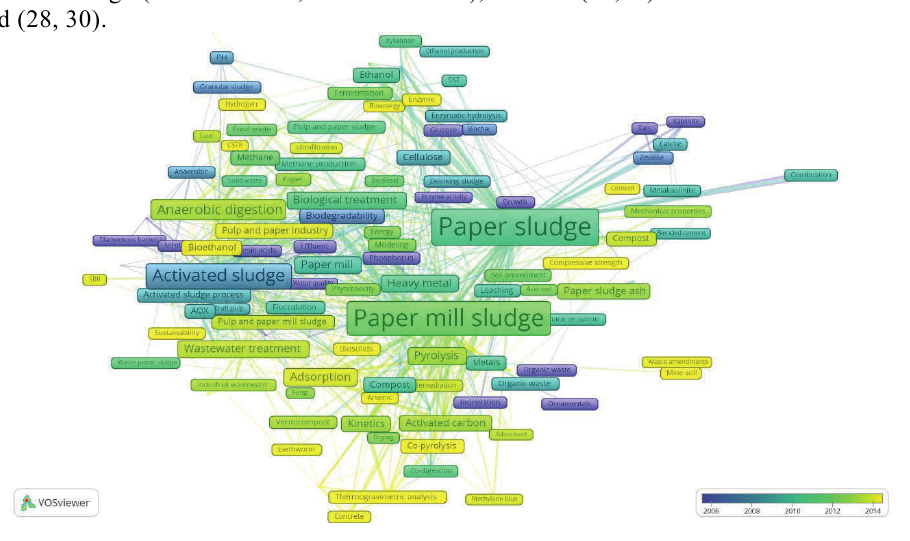
Fig. 5. Bibliometric map screenshot focused on the co-occurrence of author keywords with the overlay mapping setting and minimal term encounters were restricted at least five. It is indeed fascinating to see where a specific keyword is configured. The word,